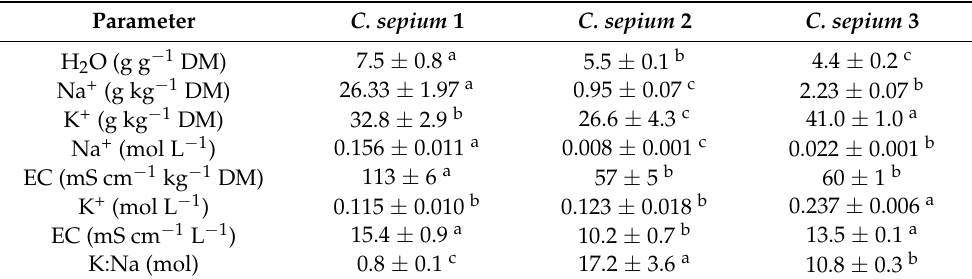
Table 2. Water content, Na + and K + concentration and electrical conductivity (EC) in leaf blades of different accessions of Calystegia sepium in natural conditions, expressed either on dry mass or tissue water basis.